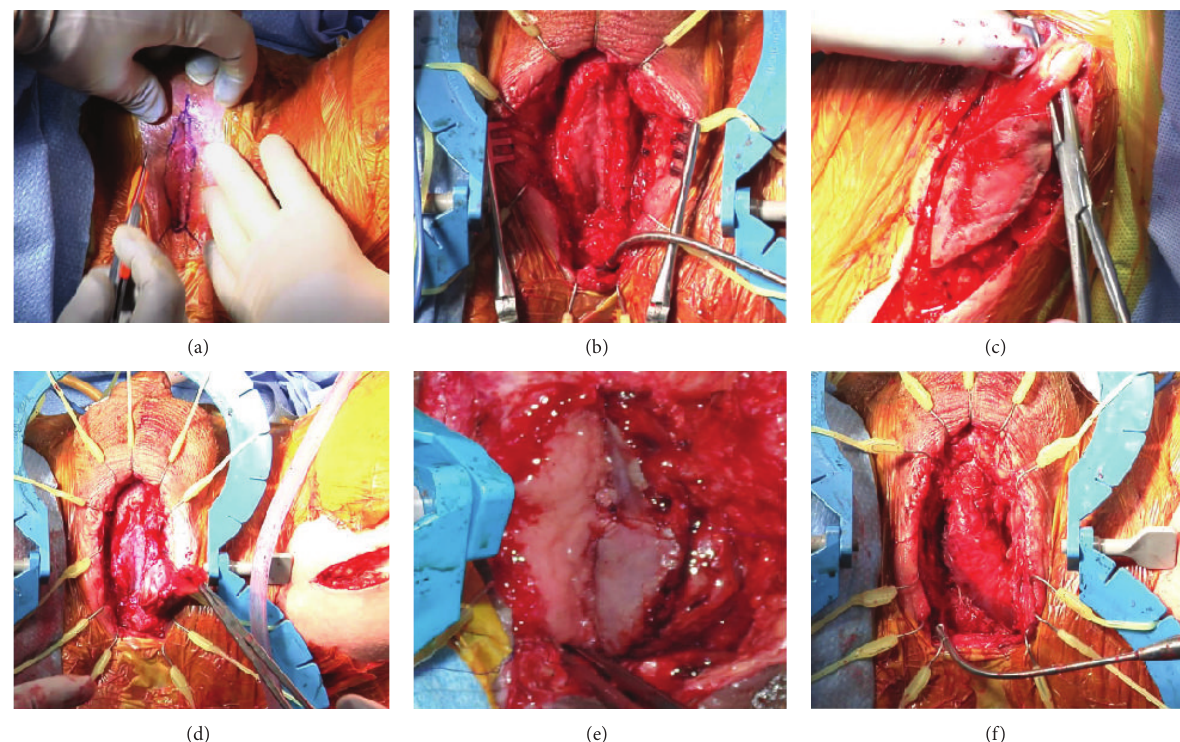
Figure 3: Steps of the Stage 2 procedure. (a) Engrafted perineal urethrostomy at 8 weeks, (b) dorsal plate dissected, (c) gracilis-buccal mucosa composite harvest, (d) gracilis tunneled into the perineal incision, (e) dorsal (left) and ventral (right) plates anastomosed on the left side, and (f) completed anastomosis of ventral and dorsal hemi-plates.